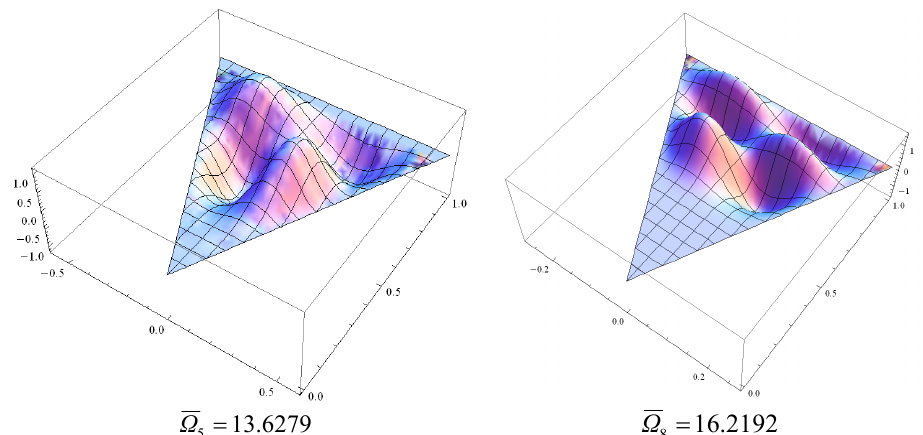
Figure 2. The 1st, 2nd, 3rd, 4th, 5th, and 8th mode shapes of a right triangular glass/epoxy plate with CCC boundary conditions all around.